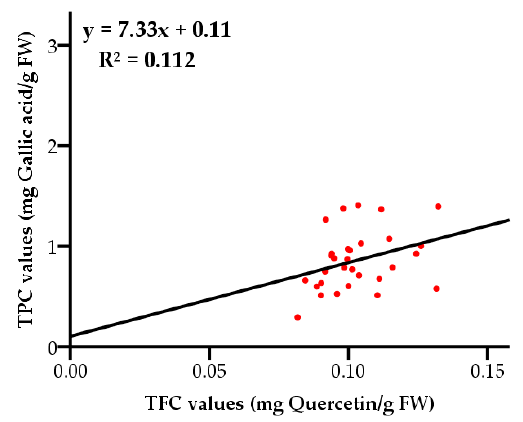
Figure 7. Correlation between total phenolic contents and total flavonoid contents.